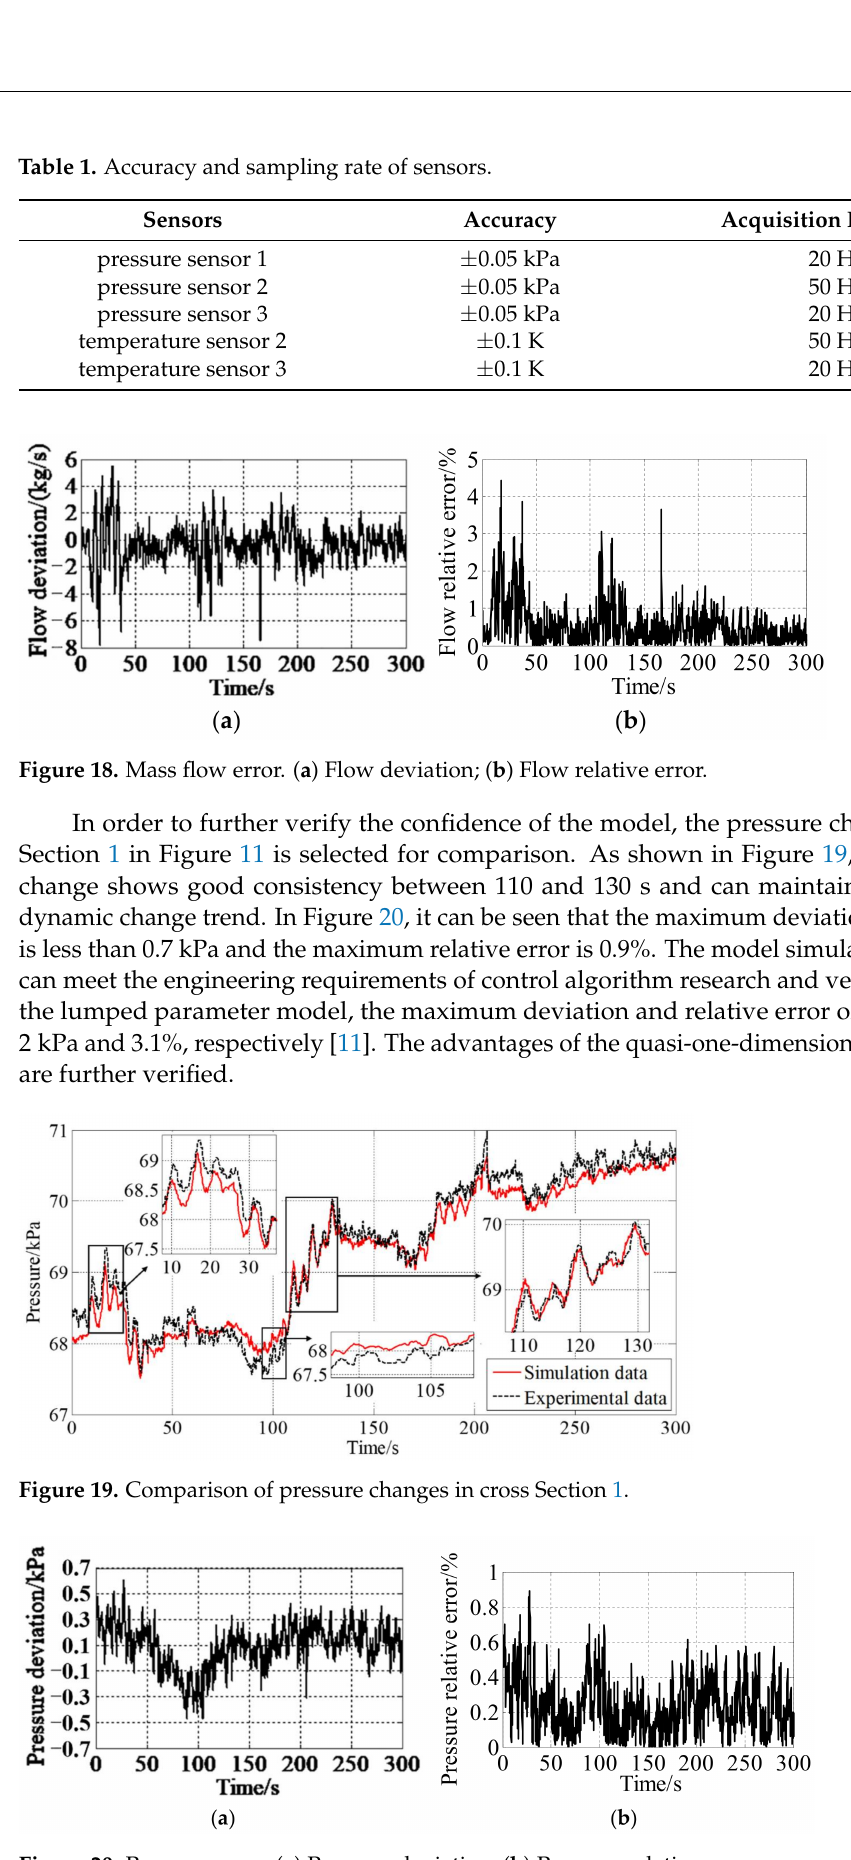
Figure 20. Pressure error. ( a ) Pressure deviation; ( b ) Pressure relative